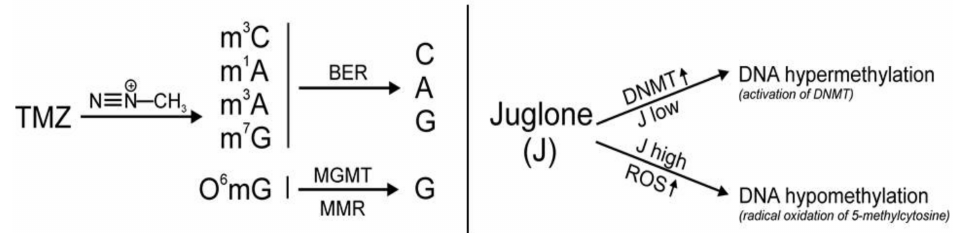
Figure 1. Chemical formulae of juglone (Mw 174,16) and temozolamide (Mw 194,15).